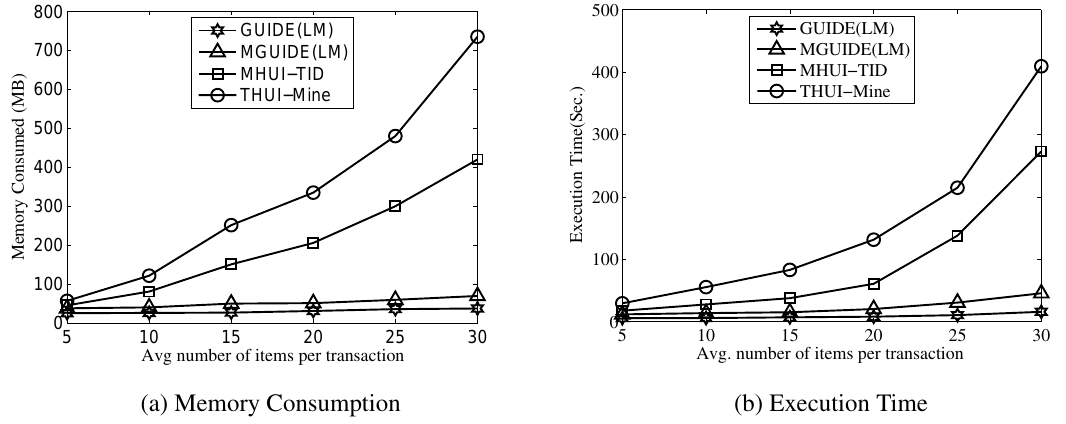
Fig. 6: Performance with varying average number of items per transaction